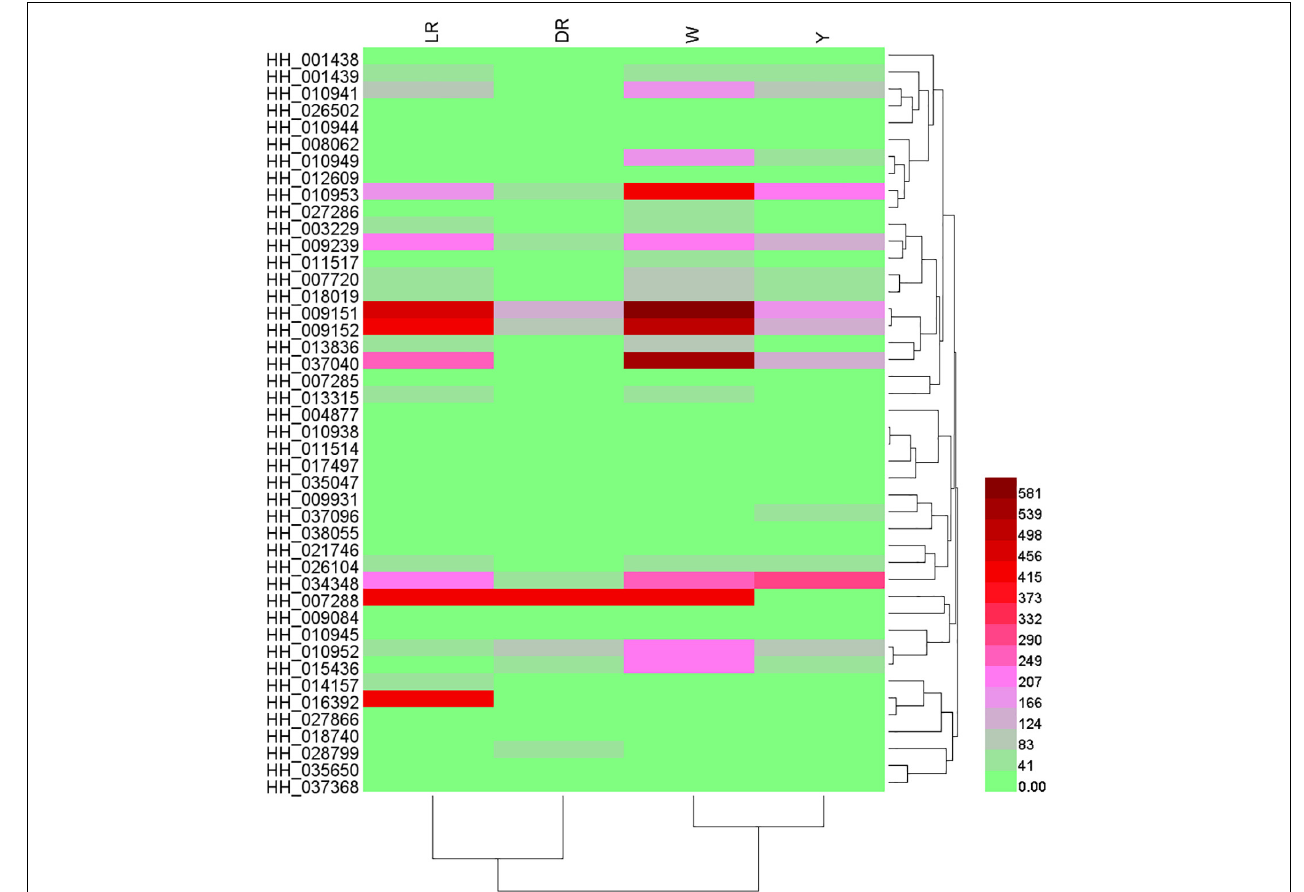
FIGURE 4 | Heatmap of annotated flavonoid biosynthesis genes among the four different-colored flower of safflower. The heatmap was drawn based on relative expression of annotated flavonoid biosynthesis genes. W, white; Y, yellow; LR, light red; DR, deep red.